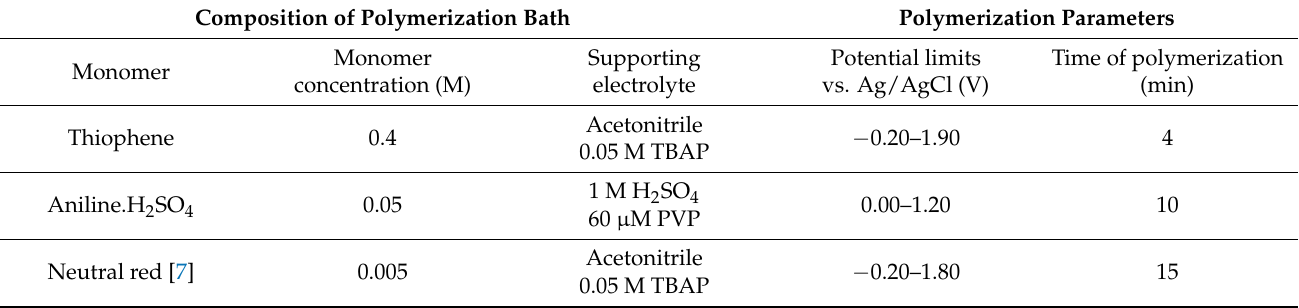
Table 1. Conditions for the electropolymerized individual and multilayers. All polymers